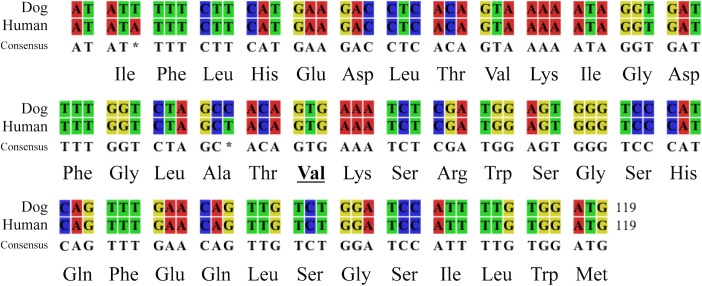
DNA and amino acid sequences of human (NM_004333) BRAF exon 15 and dog BRAF gene (XM_005629550.1).The sequences are highly conserved between human and dog, including valine at codon 600 in human BRAF (underlined) and at codon 450 in canine BRAF.